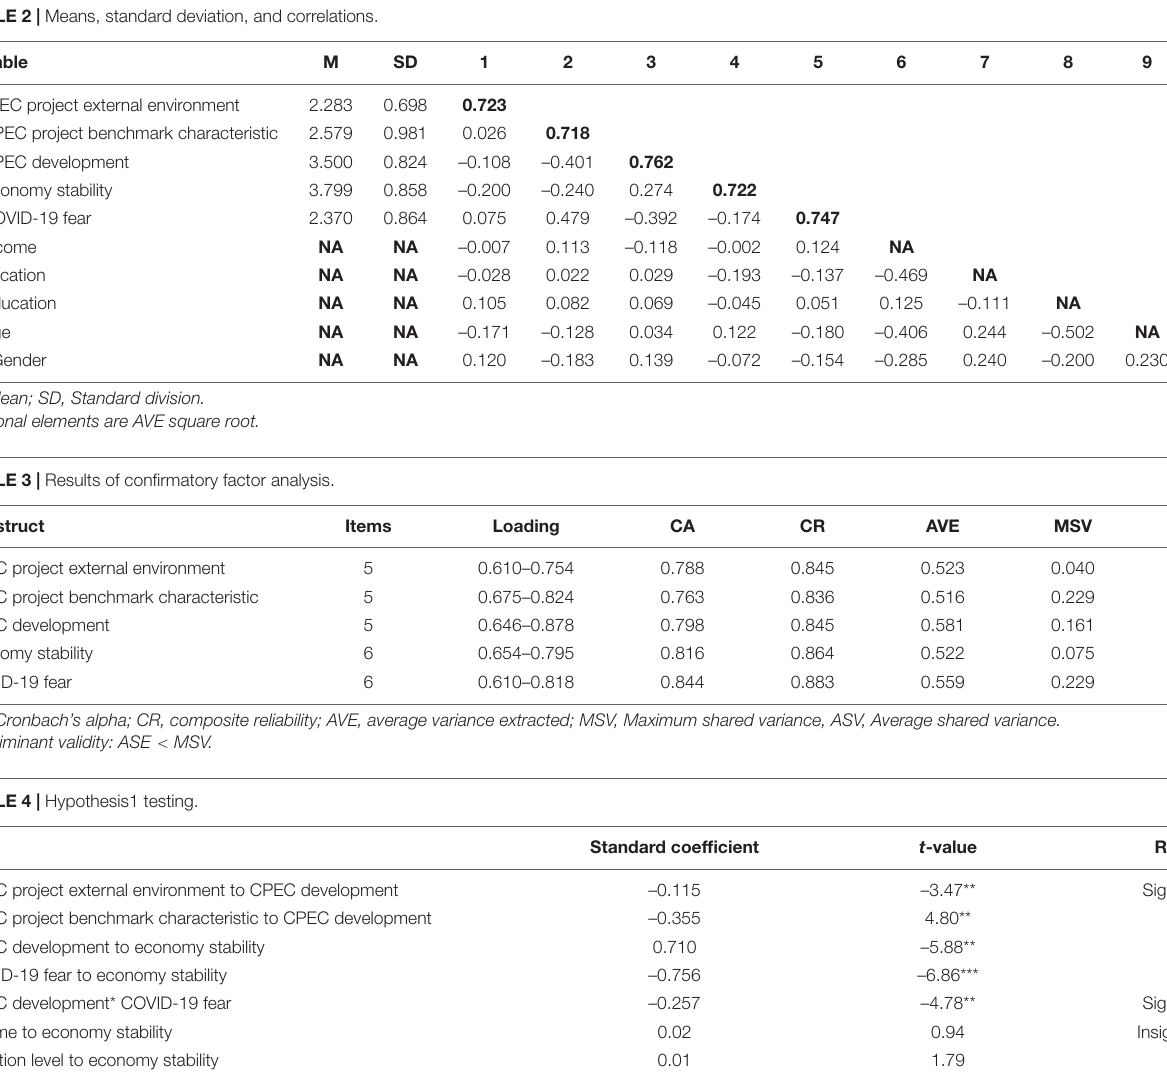
TABLE 2 | Means, standard deviation, and correlations.